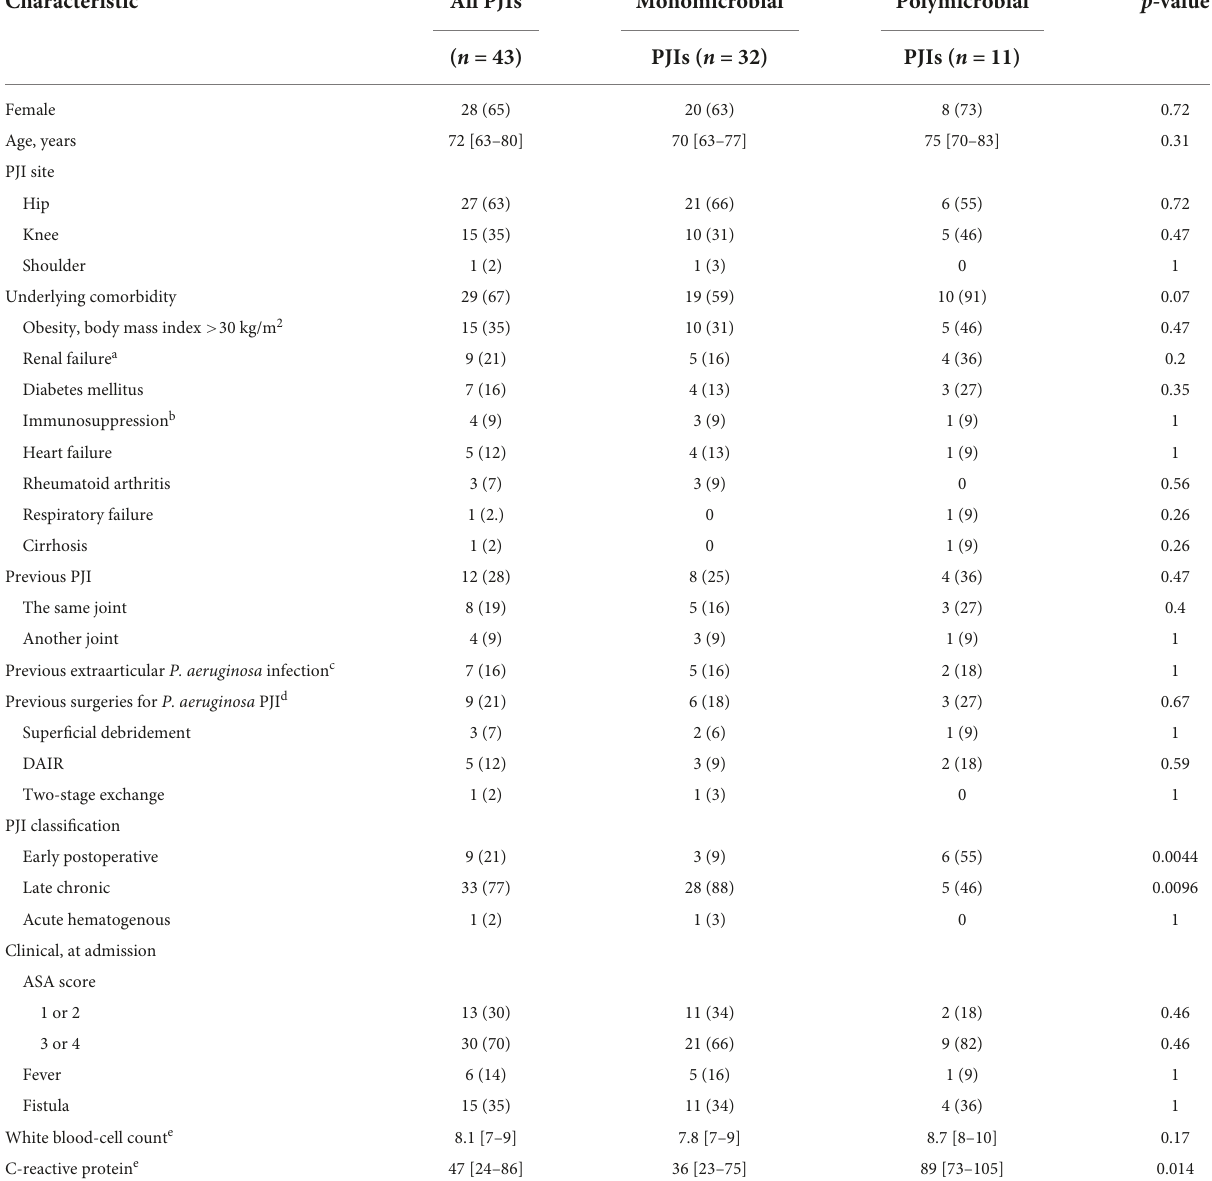
TABLE 1 Baseline characteristics of 43 patients with P. aeruginosa PJIs and according to type of infection. Characteristic All PJIs Monomicrobial